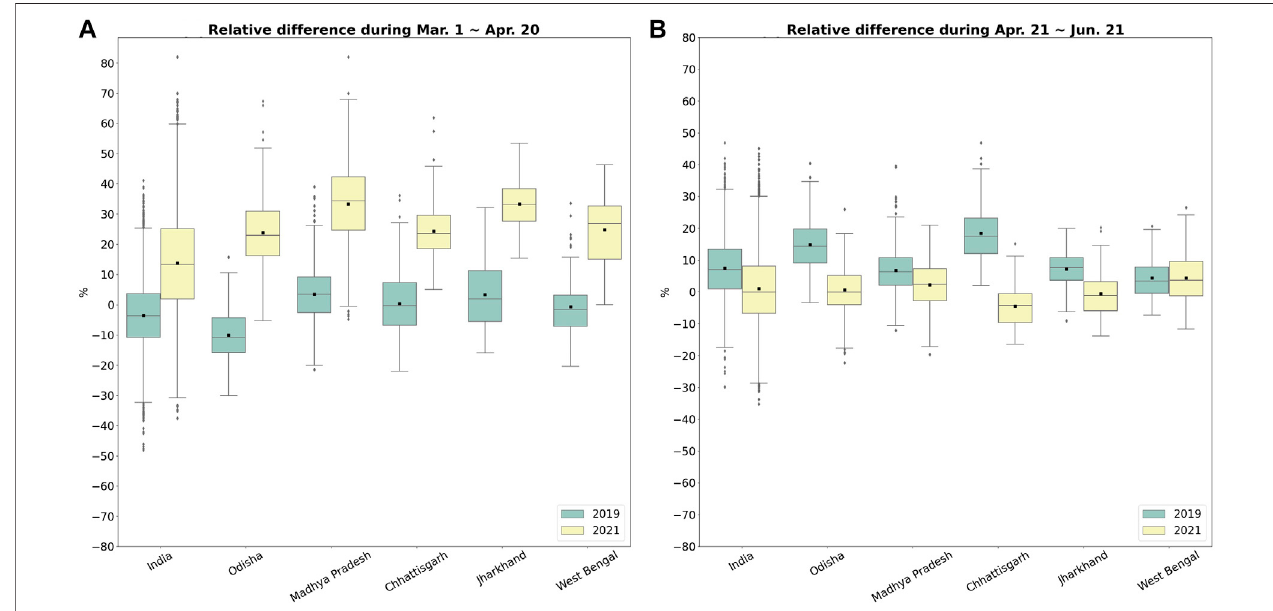
FIGURE2| BoxplotsofNO 2 relativedifferencefrom10-yearsmeanduring (A) Mar.1~Apr.20and (B) Apr.21~Jun.21in2021and2019.Thedotsindicateoutliers in the data, which are identi fi ed by the interquartile range (IQR) method.